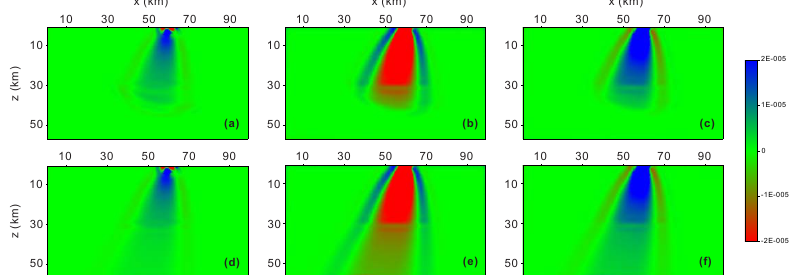
Figure 8. Misfit gradients in the plane at y = 61km at two times. The top and bottom panels correspond to t = 18 and 24s, respectively. The left, middle, and right panels correspond to the misfit gradients in terms of ρ , V P , and V S , respectively. The color scale is shown on the right side of the